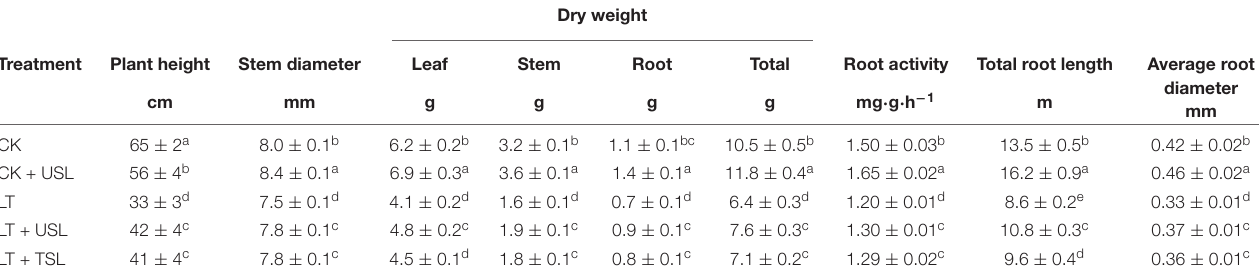
TABLE 1 | Effects of USL on the plant and root growth indices, biomass allocation, and root activity of tomato seedlings under low temperature (LT).